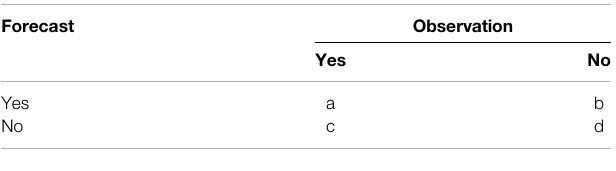
TABLE 2 | Heatwave test classi fi